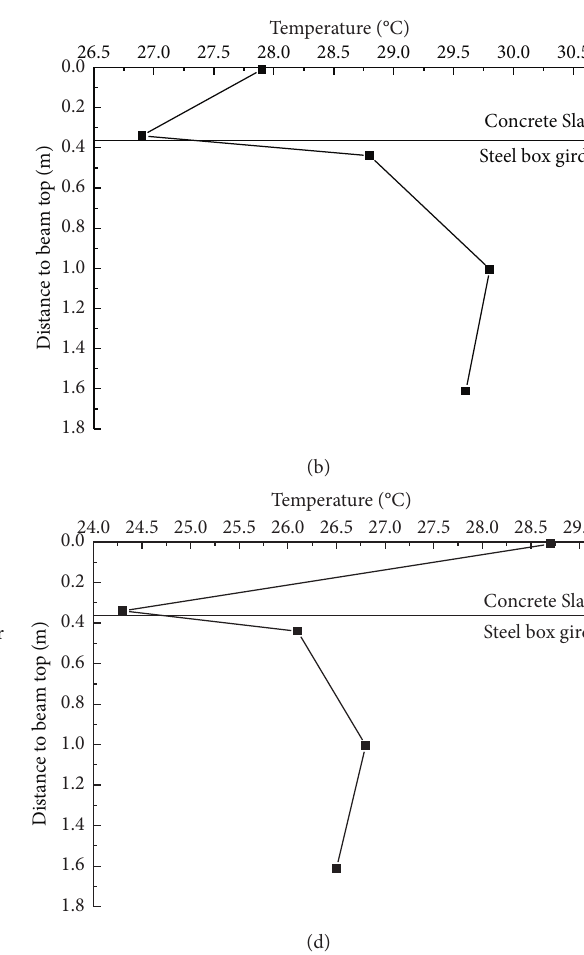
Figure 10: Most unfavourable curves of the temperature rise gradient on the vertical section. (a) West section on June 7. (b) East section on June 7. (c) West section on June 10. (d) East section on June